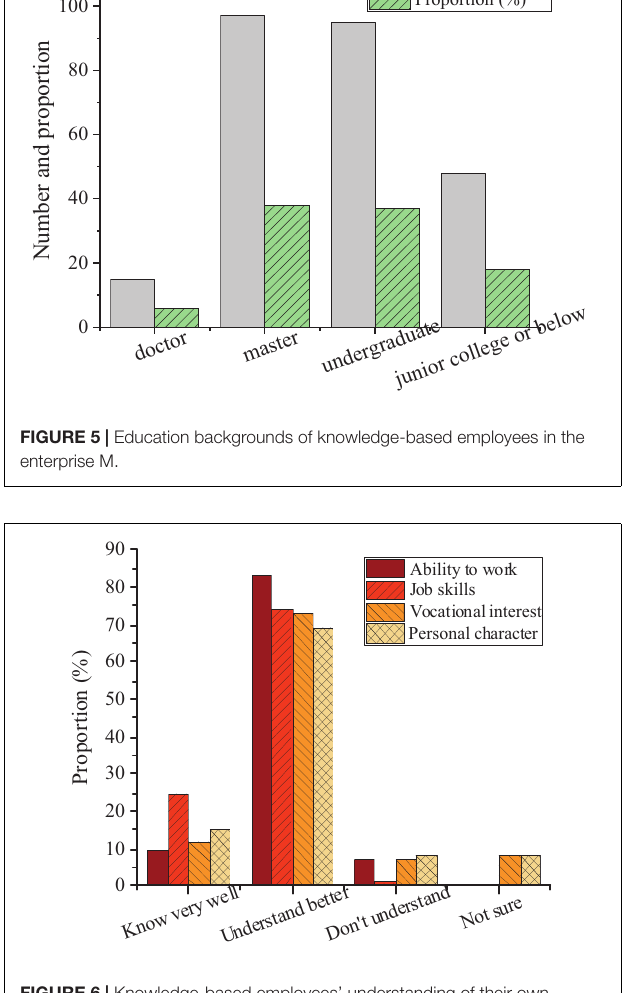
80% of the employees hold that they know very well about their abilities, but about 15% of the employees state that they don’t understand or they are not sure about their vocational interests and personal character. Figure 7 shows the survey results of knowledge-based employees’ satisfaction with the external environment of the enterprise M, demonstrating that employees are not satisfied with the training mechanism and promotion mechanism.